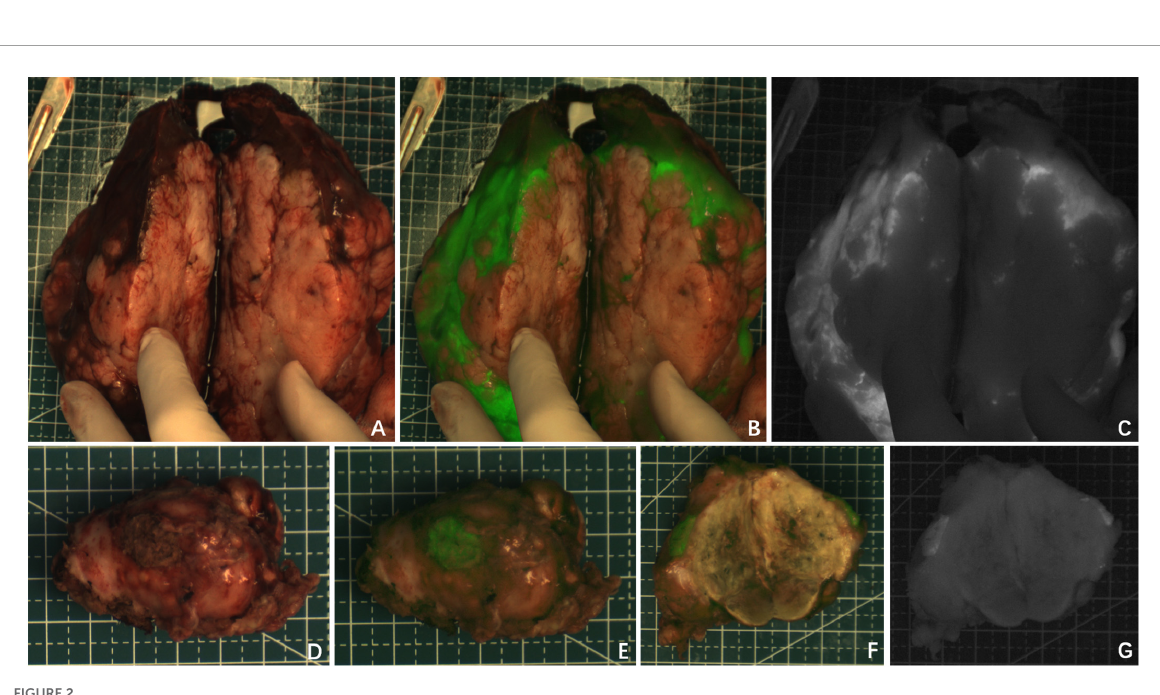
FIGURE2 Case 5 and 7. The near infrared photography of the tumor in vitro showed rim fluorescence imaging. (A–C) Case 5; (D–G) Case 7. The white-light image, fusion image and fluorescence image are shown in turn from left to